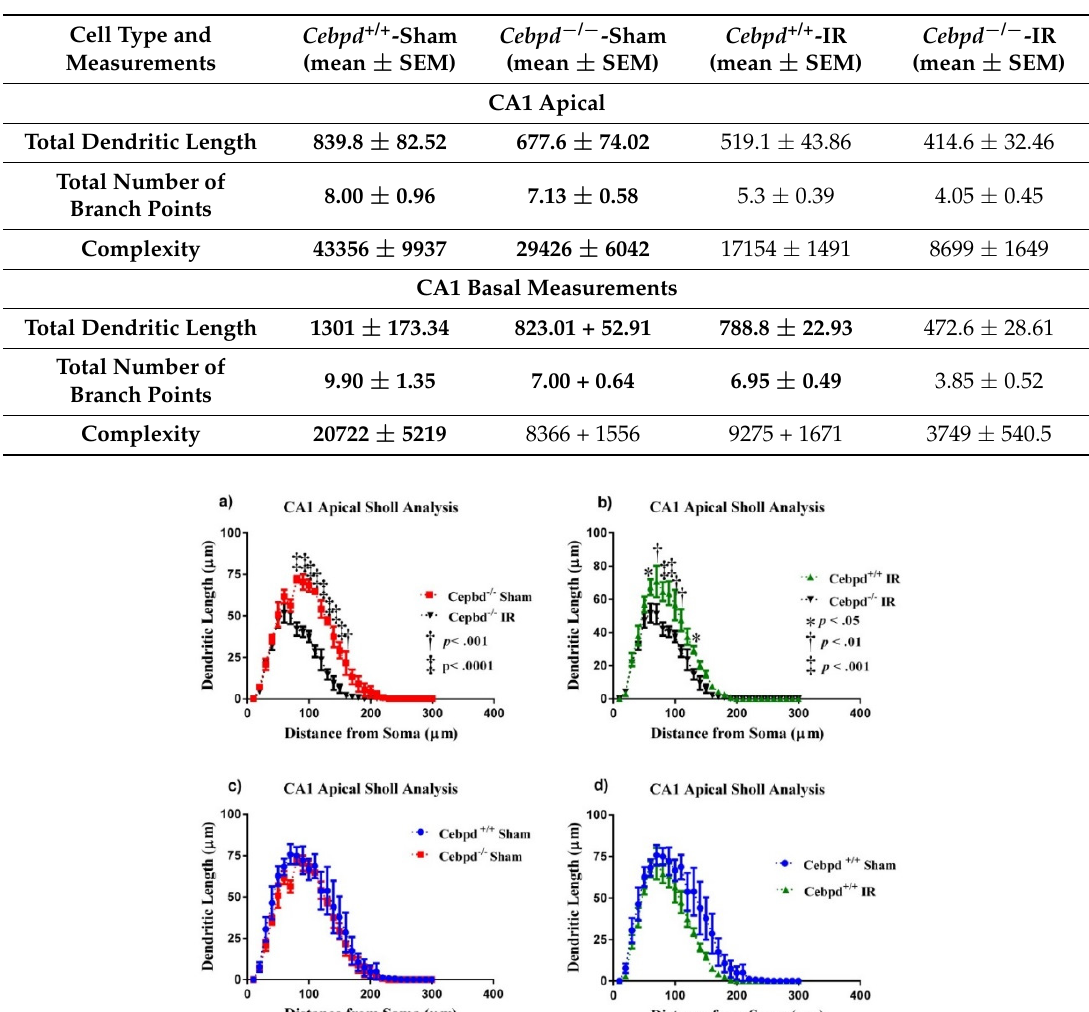
Table 2. Analysis of CA1 apical and basal neurons in aged Cebpd +/+ and Cebpd − / − mice. **** Bold figures represent significant compared to Cebpd − / − -IR.